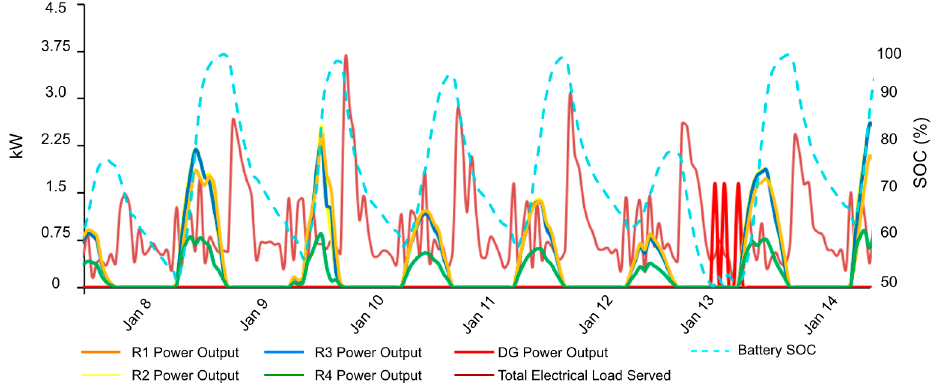
Figure 14. HOMER’s time series simulation of the system during low solar PV production.